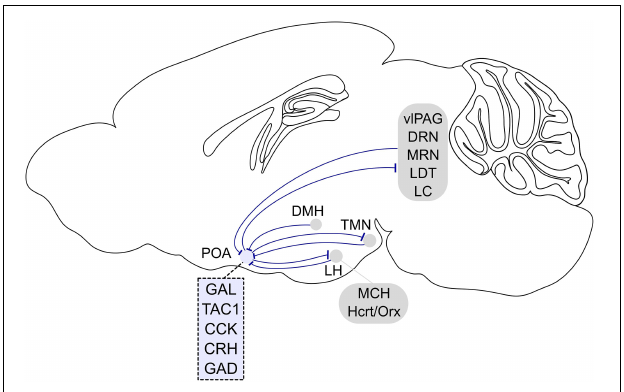
FIGURE 2 | Afferent and efferent projections of sleep regulatory POA neurons. Sleep promoting GABAergic POA neurons inhibit histamine neurons in the tuberomammillary nucleus (TMN). In turn, histaminergic TMN neurons project to the POA, and histamine indirectly inhibits putative VLPO sleep neurons. POA GABAergic neurons also densely project to the lateral hypothalamus (LH) and directly inhibit hypocretin/orexin (Hcrt/Orx) neurons. The POA in turn receives inputs from the LH, and a small fraction of neurons contain melanin-concentrating hormone (MCH) or Hcrt/Orx. GABAergic neurons in the LH also directly innervate POA galanin neurons. The POA receives inputs from dorsomedial hypothalamus (DMH) galanin neurons that are NREM promoting and REM suppressing. POA neurons project to brainstem regions such as the ventrolateral periaqueductal gray (vlPAG), raphe nuclei (DRN, MRN), laterodorsal tegmental nucleus (LDT), and locus coeruleus (LC). In turn, the POA receives inputs from these brain stem regions. Molecular markers labeling sleep regulatory POA neurons are galanin (GAL), tachykinin 1 (TAC1), cholecystokinin (CCK), and corticotropin-releasing hormone (CRH). Most sleep neurons are GABAergic and express GAD (glutamic acid decarboxylase). Sagittal brain scheme adapted from Allen Mouse Brain